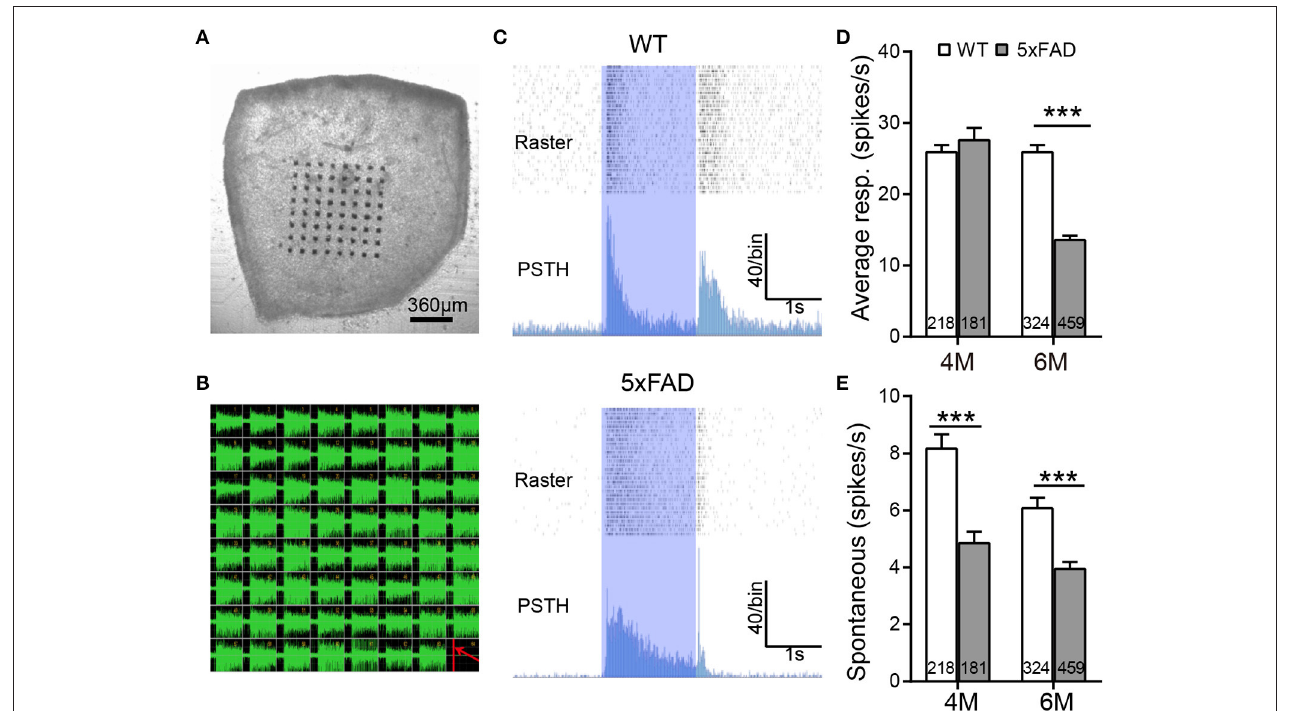
FIGURE 6 | The light response of individual ganglion cells is reduced in 5xFAD mice at 6 months. (A) Illustration of an isolated retinal tissue placed on an 8 × 8 multielectrode array. (B) Spikes recorded from each electrode in response to a saturated flash (light intensity (4.68 × 10 7 photons/ µ m 2 /s) whose onset is indicated by a red line in the lower right corner of the array. (C) Examples of spiking responses from WT and 5xFAD RGCs. For each cell, the top panel shows a raster plot from 30 repeats, and the bottom panel shows the corresponding PSTH. The 2-s light stimuli are indicated as blue regions. (D) Average firing rate of RGCs within the 2-s light stimuli was significantly reduced at 6 months in 5xFAD. (E) Spontaneous firing was greatly decreased in 5xFAD mice at both 4 and 6 months. The numbers within the bars represent the number of responsive cells recorded from retinas of three animals. *** p < 0.001, two-way